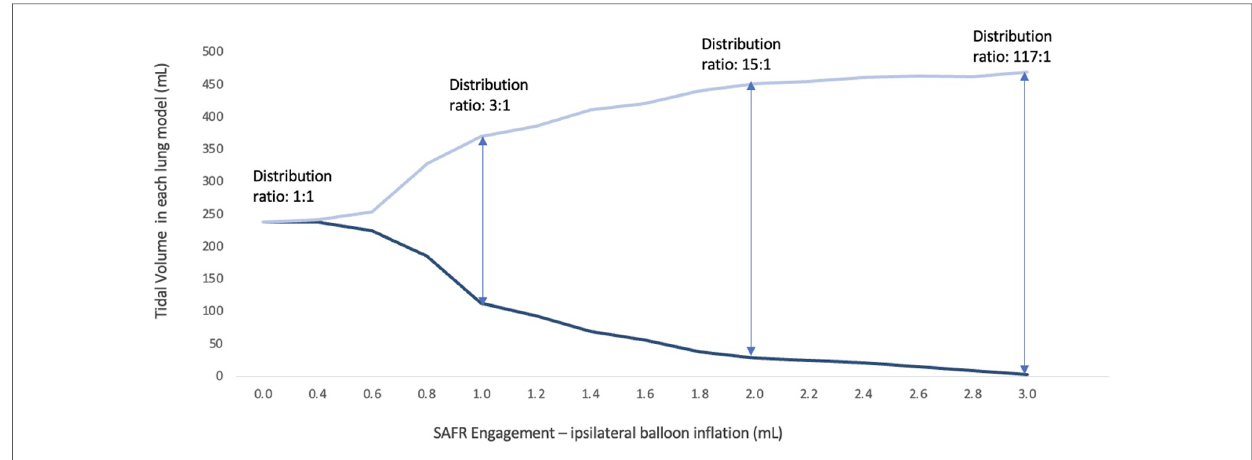
FIGURE 3 Volume distribution between the two lung models with a gradual SAFR engagement using tapered intraluminal balloon in fl ation.